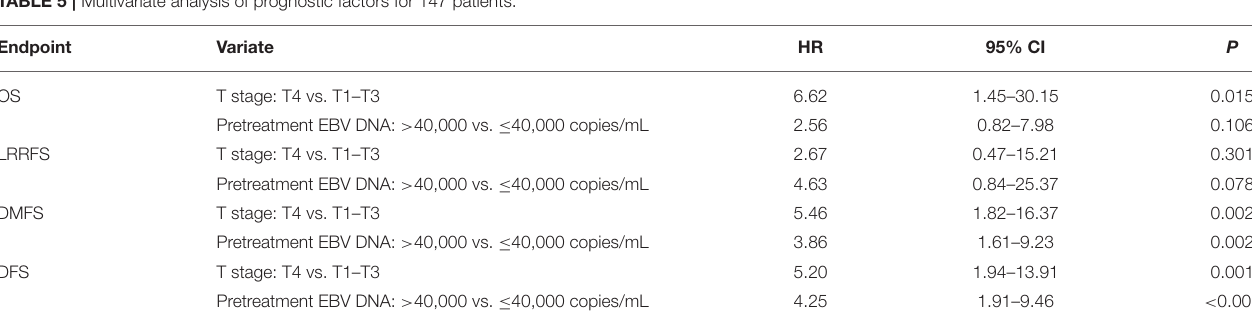
TABLE 5 | Multivariate analysis of prognostic factors for 147